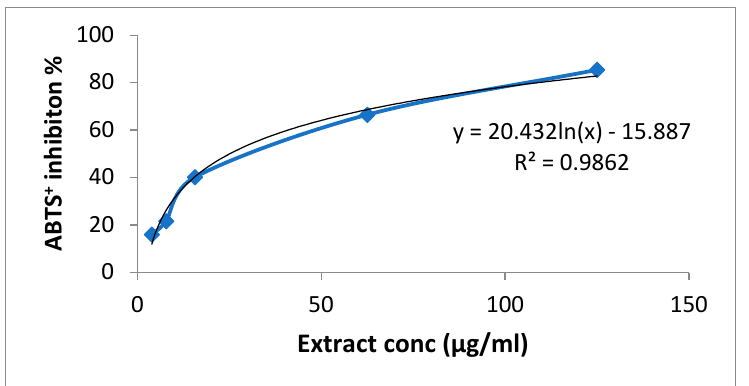
Figure 4. ABTS + percentage inhibition of phlorotannins extracted from S. linifolium brown alga.